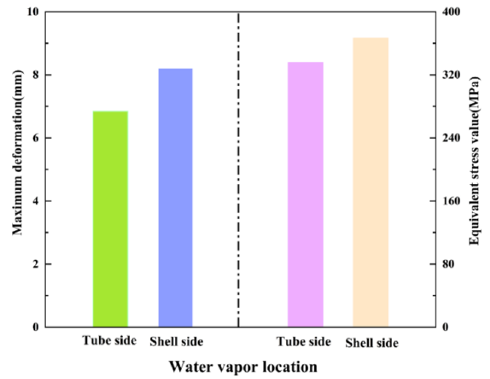
Figure 10. The average equivalent stress value and maximum deformation when the heat transfer working medium in the heat exchanger is located at different positions.